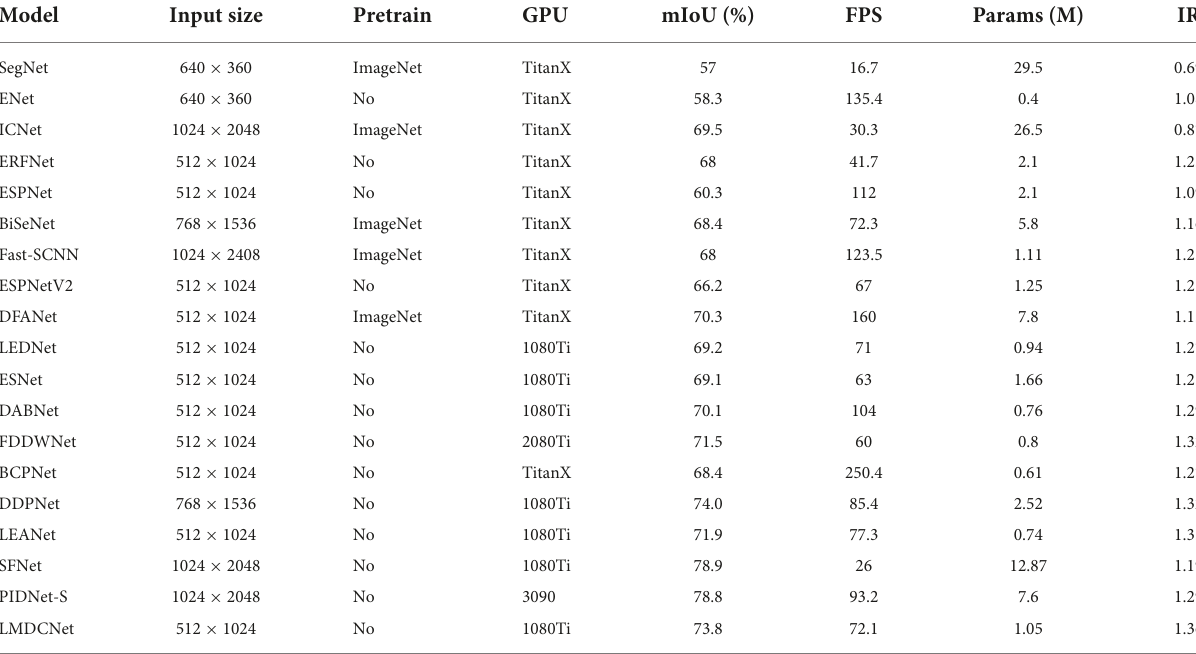
TABLE 4 Evaluation results of our lightweight multi-dimensional dynamic convolutional network (LMDCNet) and other state-of-the-art real-time semantic segmentation models on the Cityscapes test